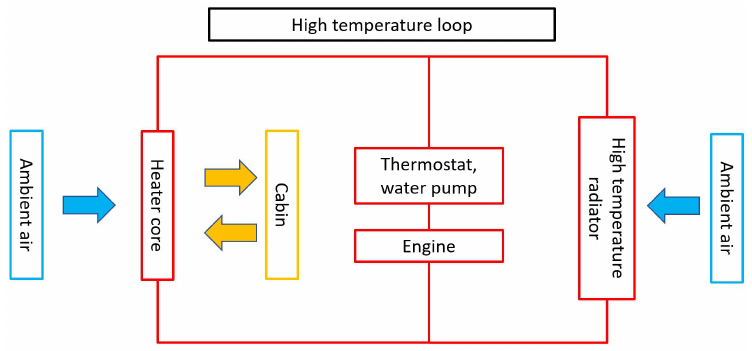
Figure 1. Scheme of a high temperature